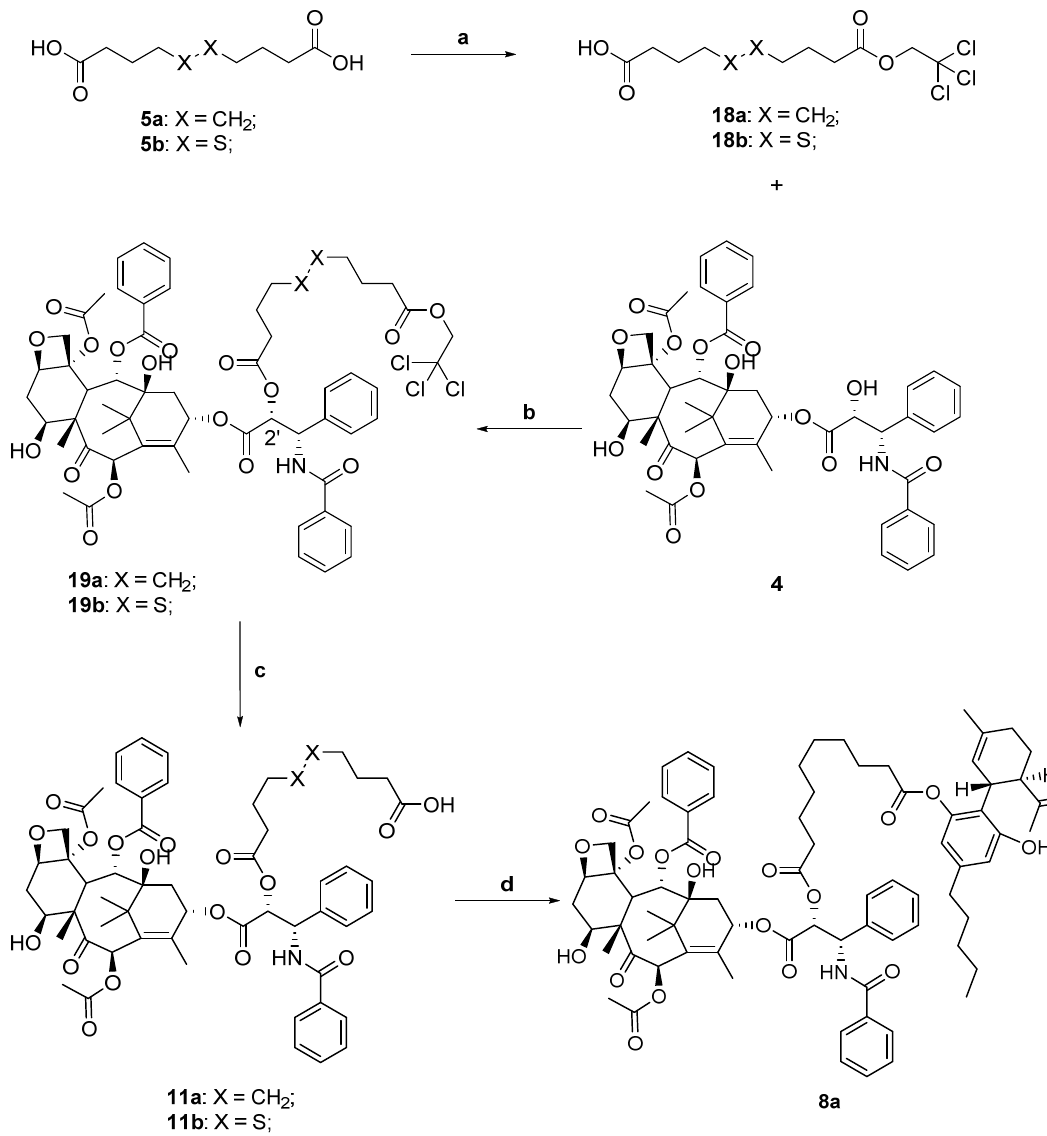
Scheme 5. Synthesis of paclitaxel-CBD conjugate 8a